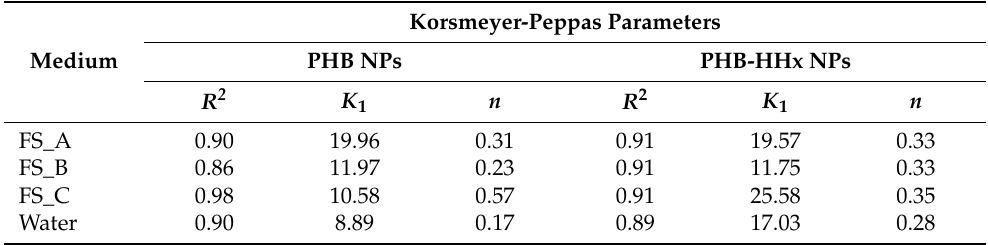
Table 3. Korsmeyer–Peppas Model parameters values for EO release in water and in three Food simulants: FS_A, ethanol at 10%; FS_B, acetic acid at 3%; FS_C, ethanol